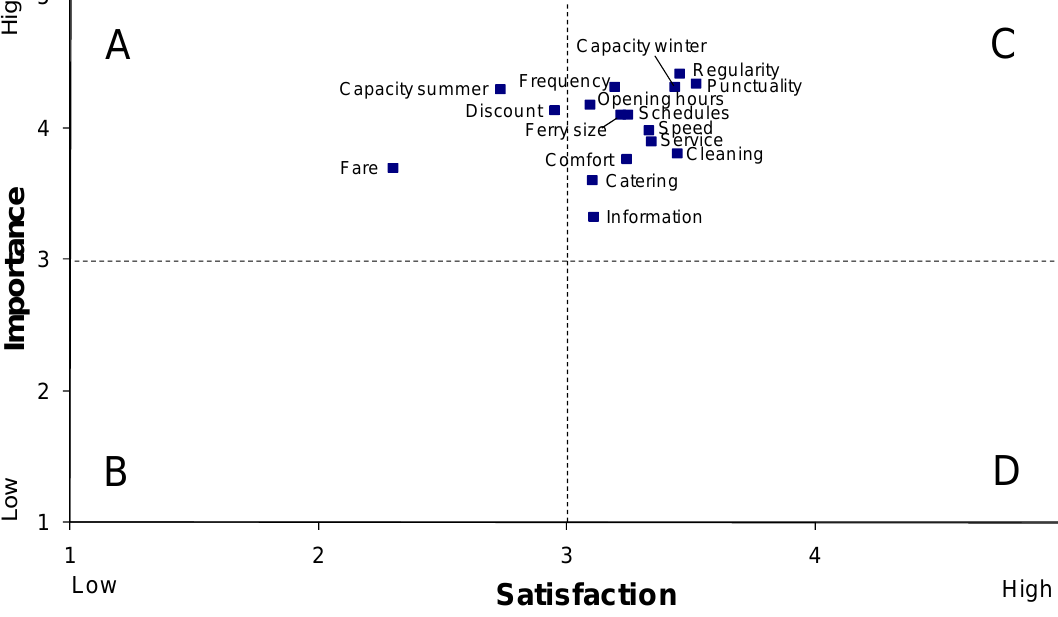
Figure 1. Enterprises assessment of importance and satisfaction with service elements in Norwegian ferry operations.